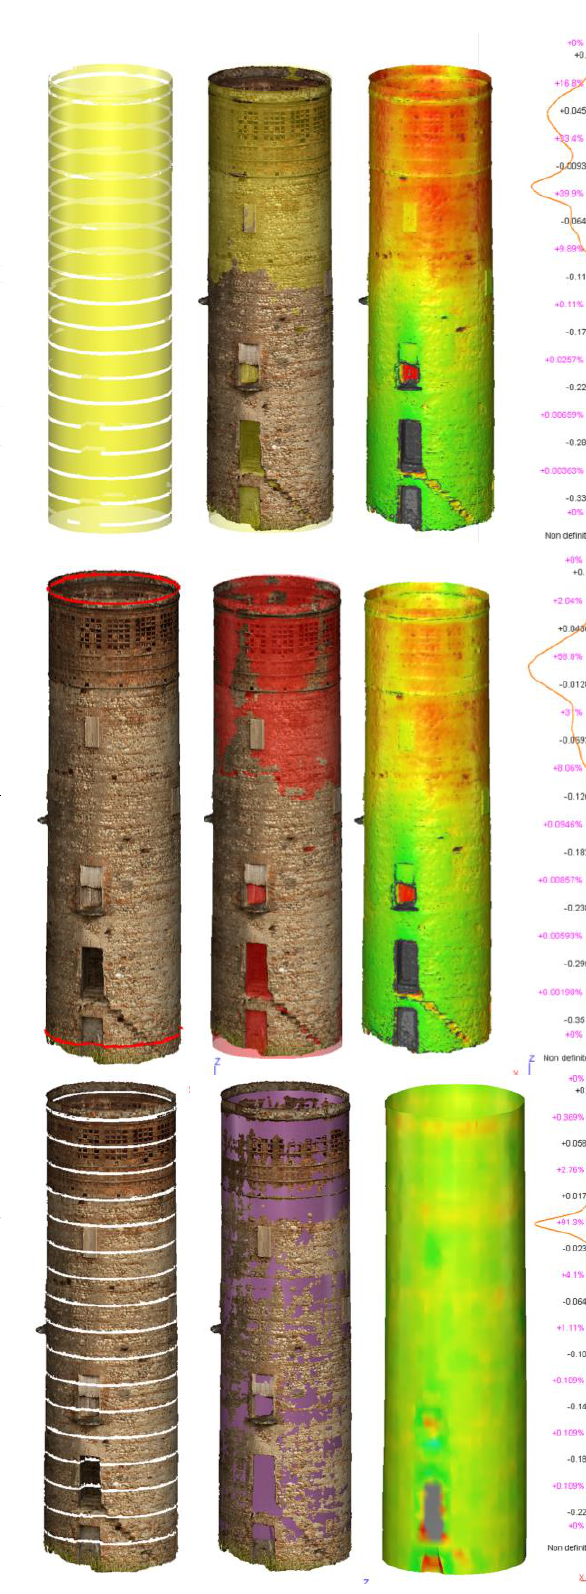
Figure 6. (A) 3D model analysis and approximation to a mean cylinder surface (r=2.417m); (B) 3D model analysis and approximation to a mean trunk-cone surface (r=2.371412/ R=2.451233); (C) 3D model analysis and approximation to a 3D mesh that better fit the structure deformation